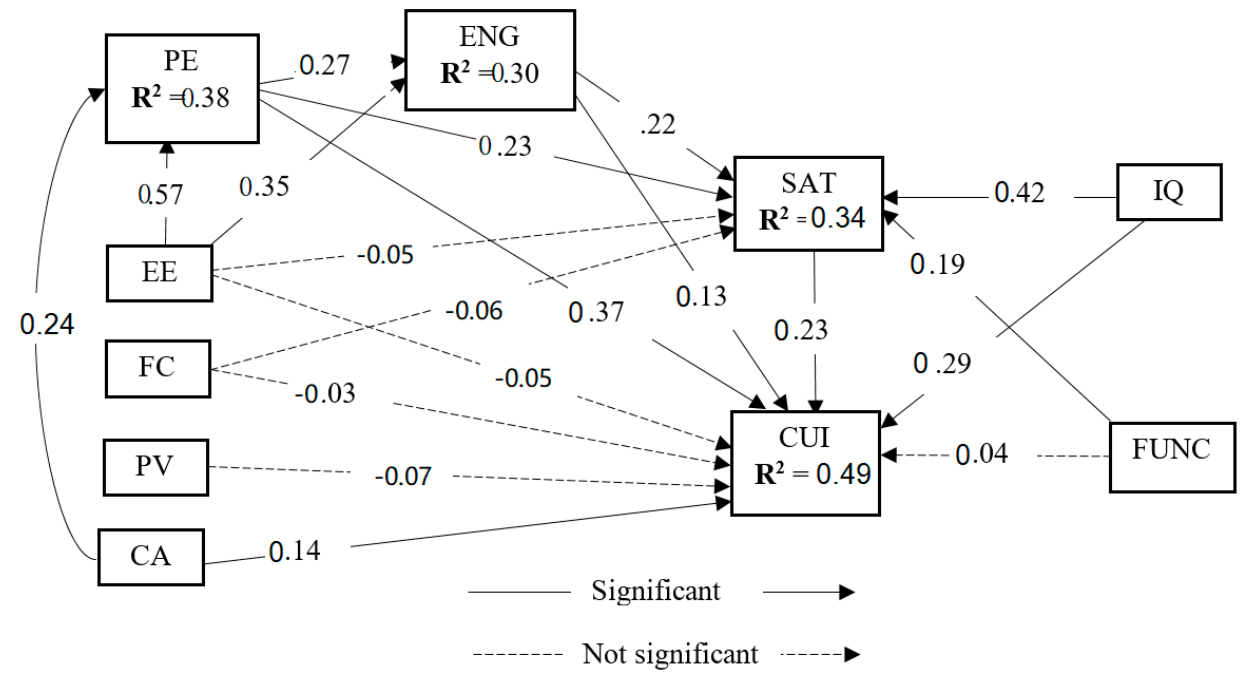
Figure 4. Structural model. Note: All mediating hypotheses, i.e., H10a (PE → ENG → CUI), H10b (EE → ENG → CUI), H11a (PE → SAT → CUI), and H11b (EE → SAT → CUI), except H11c (FC → SAT → CUI), are significant. Table 5. Model fit results.